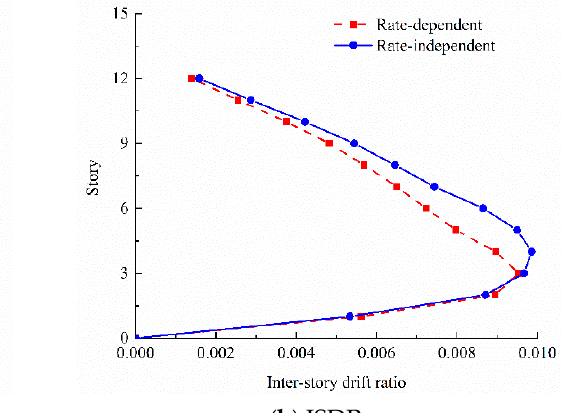
Figure 9. Comparison of the rate-dependent and rate-independent numerical results of roof displacement and ISDRs (Taft PGA = 0.6 g).